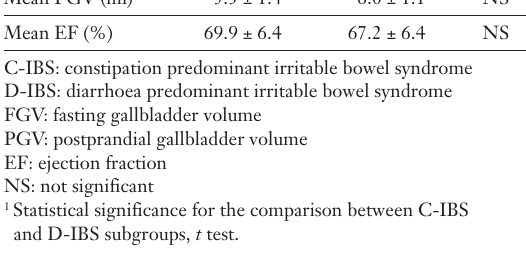
The mean FGV, PGV and EF values of gall- bladder in subgroups of IBS (mean ±